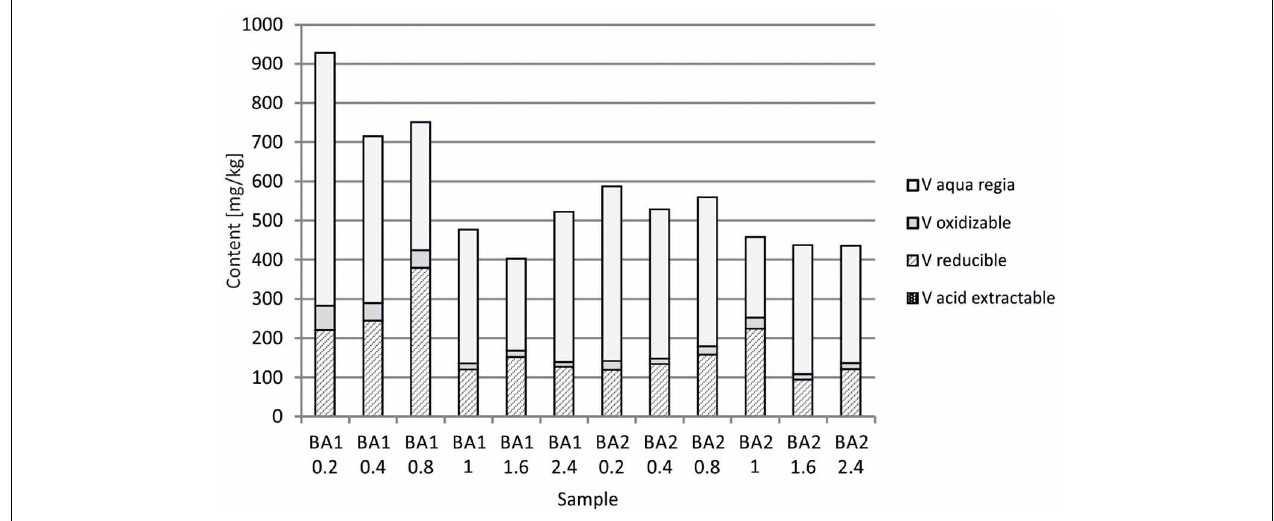
FIGURE 11 | Sequential extraction of the Berg Aukas samples: V.